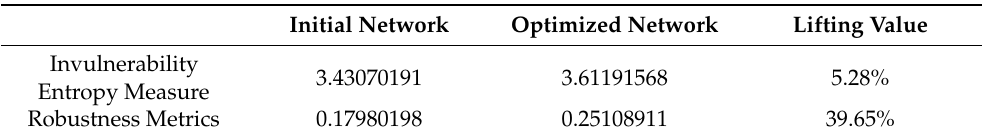
Table 2. Network invulnerability entropy measures and robustness metric before and after algorithm